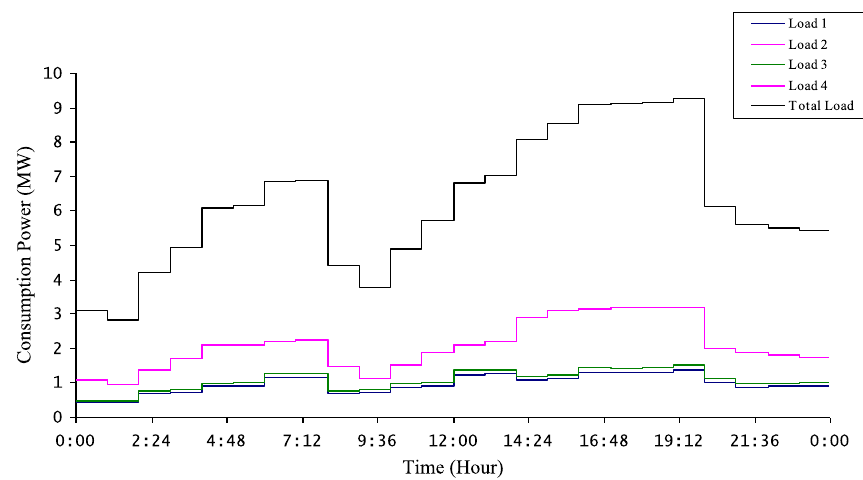
Fig. 4 Daily load curves of the microgrid example system